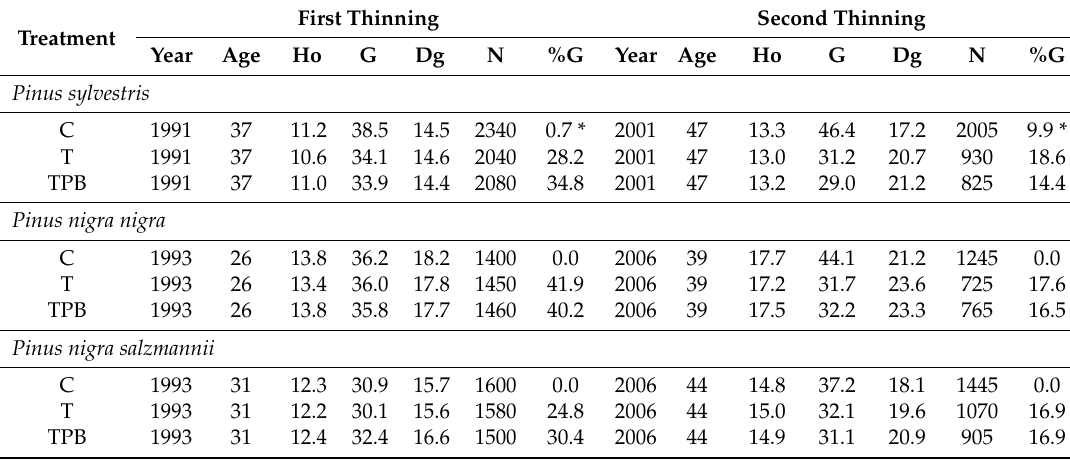
Table 1. Average attributes of the stand per treatment and quantification of thinning intensity. See Moreno-Fern á ndez et al. [4] for more